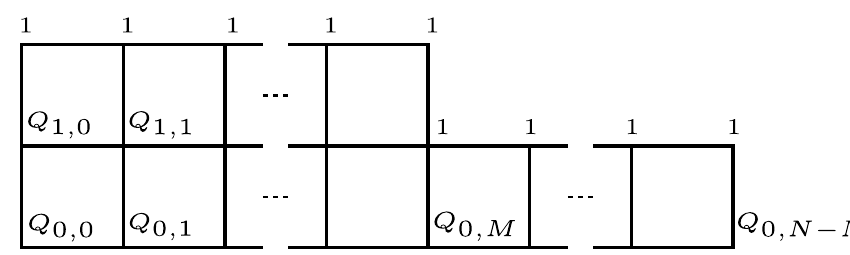
Figure 1 . Non-trivial Q -functions for the closed XXX spin